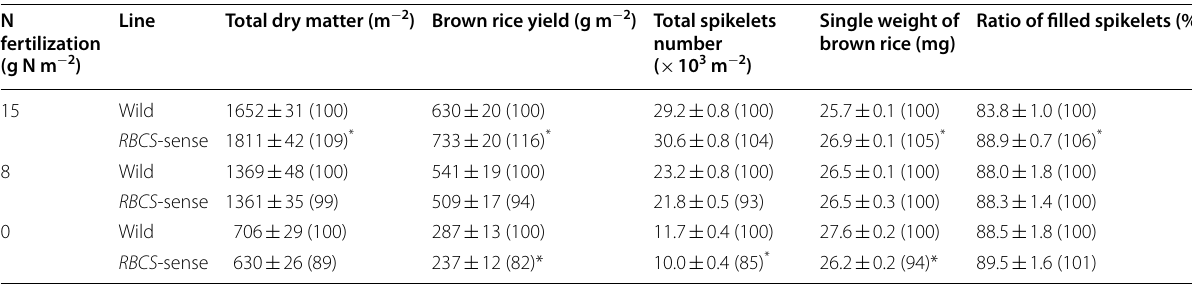
Table 1 Comparisons of total dry matter, yield, and yield components in 2021